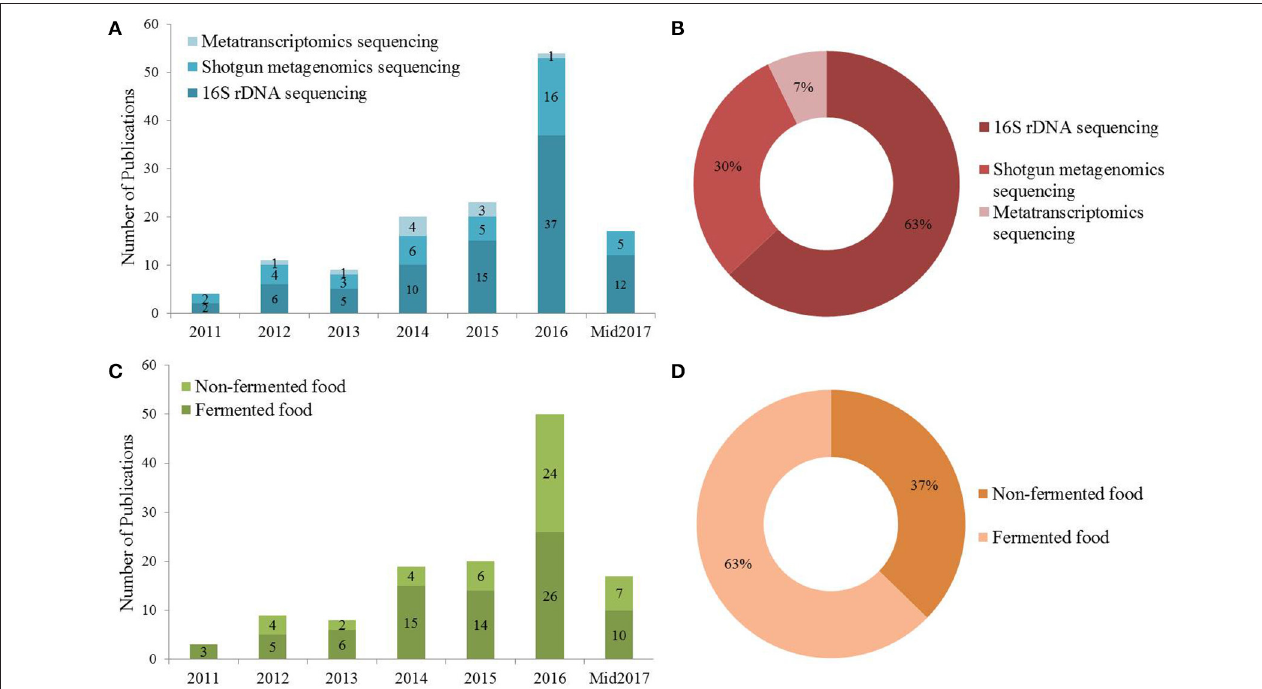
FIGURE 1 | (A) The total number of publications utilizing NGS technology investigating the microbiome associated with fermented and non-fermented food between 2011 and June 2017. (B) The proportion of different sequencing strategies used in the publications mentioned in (A) . (C) The number of publications utilizing NGS strategies to investigate fermented and non-fermented food. (D) The percentage of publications utilizing NGS approaches in investigating fermented and non-fermented